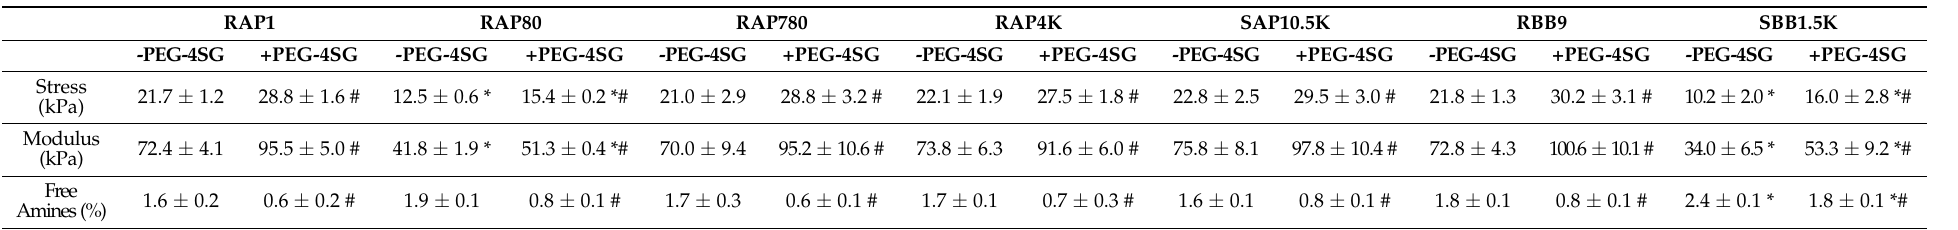
Table 2. Mechanical properties and free amine content of non-crosslinked (-PEG-4SG) and crosslinked (+PEG-4SG) gelatin samples used in this study. *: Indicates lowest ( p < 0.05) mechanical properties and highest ( p < 0.05) free amine content among non-crosslinked and crosslinked gelatin samples used in this study. #: Indicates higher ( p < 0.05) mechanical properties and lower ( p < 0.05) free amine content between non-crosslinked and crosslinked gelatin samples used in this